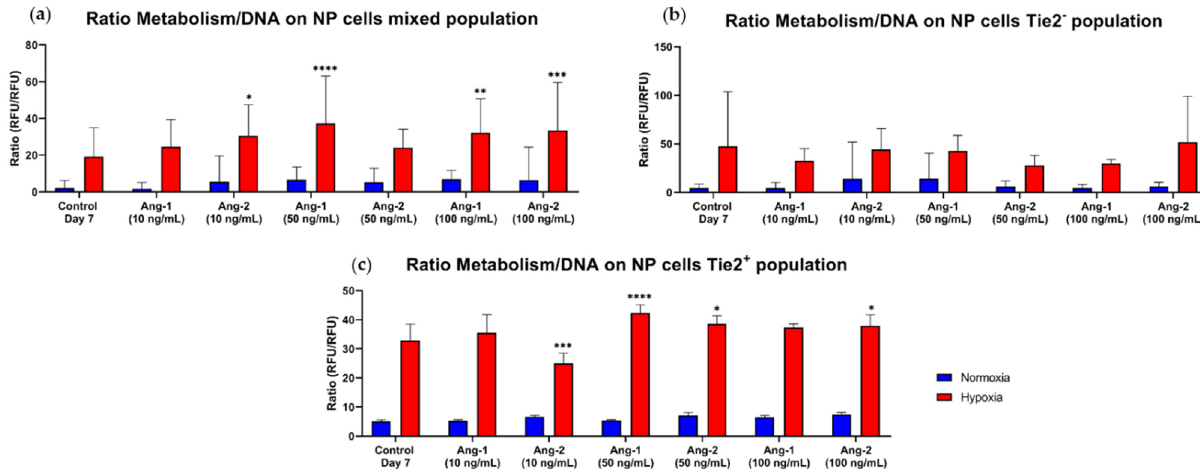
Figure 2. Metabolic activity on single-cell level of NP cells populations in normoxia and hypoxia on Day 7. Ang-1 and Ang-2 were administrated in three concentrations: 10, 50 and 100 ng/mL. The control Day 7 samples were used as reference. ( a ) Metabolic activity on single-cell level of NP cells mixed population; ( b ) metabolic activity on single-cell level of NP cells Tie2 − population; ( c ) metabolic activity on single-cell level of NP cells Tie2 + population. Bars represent mean ± SD. A p -value < 0.05 was considered significant. Asterisks within figures denote the degree of statistical relevance observed: * < 0.05; ** < 0.01; *** < 0.001; **** < 0.0001.